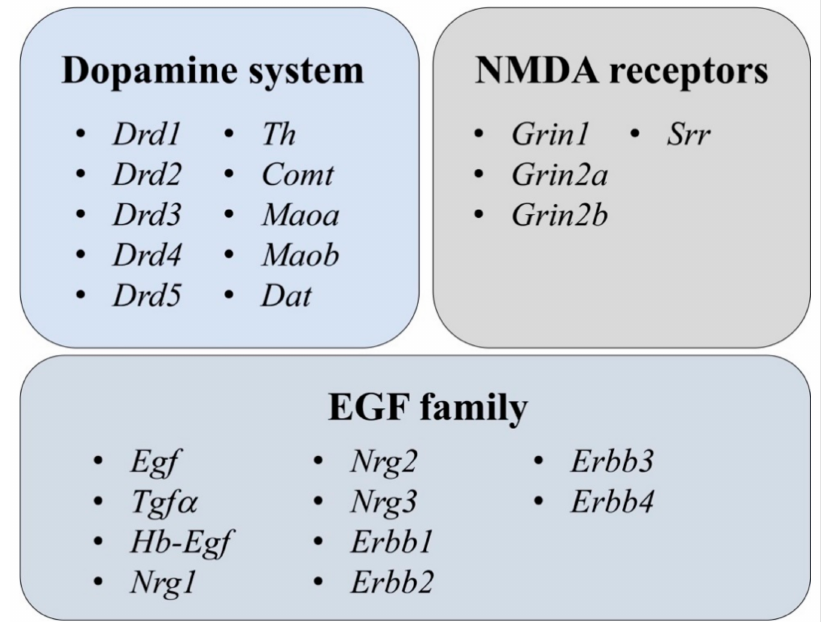
Figure 1. Measured gene expression from three large neurotransmitter/neuromodulator systems. More detailed information concerning full names and primers for genes is presented in Table